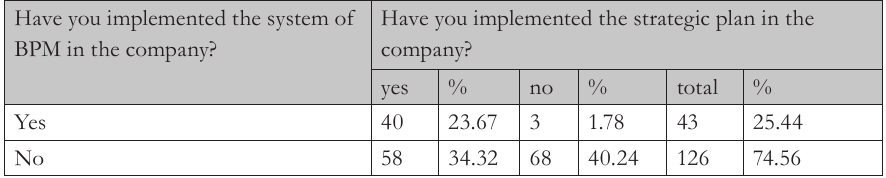
Tab. 2 – Classification of enterprises in terms of their size and use of BPM. Source: own